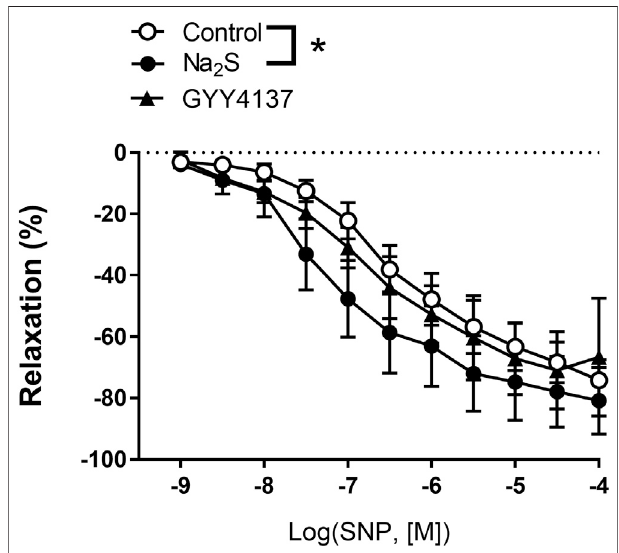
FIGURE 6 | Effect of Na 2 S and GYY4137 on relaxations induced by the NO donor, sodium nitroprusside (SNP) in small mesenteric arteries. The arteries were incubated with and inhibitor of NO synthase, L-NAME (10 µM), and Na 2 S (300 µM) ( n (cid:2) 6), or GYY4137 (1 mM) ( n (cid:2) 5), contracted with U46619 (0.3 µM) and concentration-response curves constructed for SNP. * p < 0.05, two-way ANOVA. All data are means ± SEM.